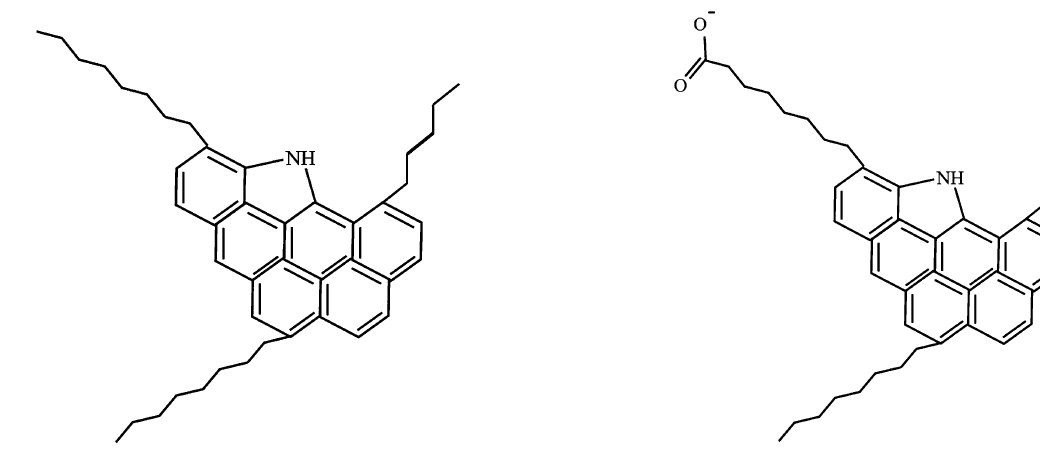
Fig. 7 Continental asphaltene structure (Kuznicki et al. 2008) Fig. 8 Anionic continental asphaltene structure (Kuznicki et al.